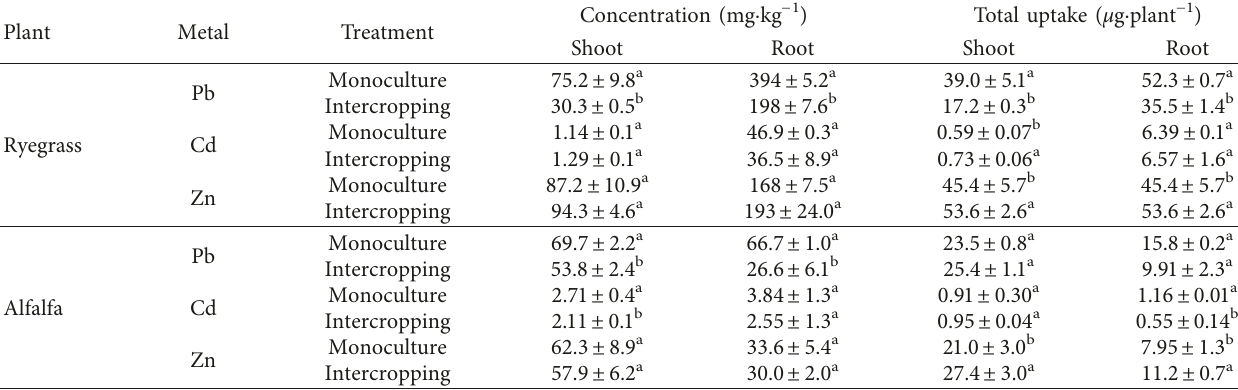
Table 3: Concentration and total uptake of metals in ryegrass and alfalfa tissues.